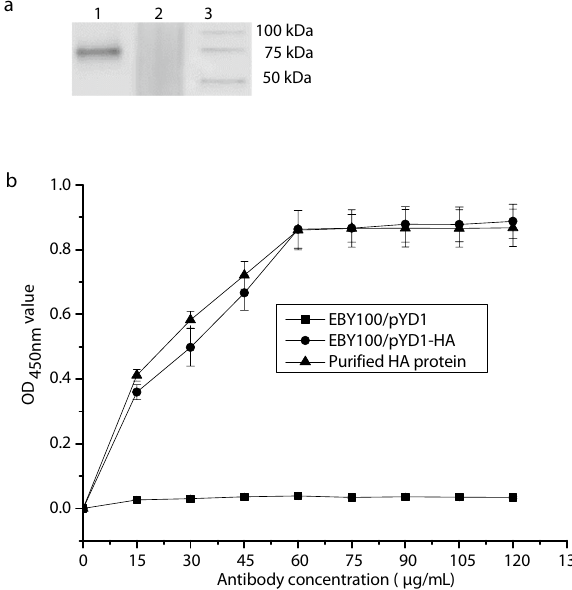
Figure 1. Determinations of expression and quantification of EBY100/pYD1-HA. ( a ) The display of cropped Western blots. Lane 1: EBY100/pYD1-HA; Lane 2: EBY100/pYD1; Lane 3: Western blot marker (Precision Plus Protein™, Bio-Rad). ( b ) Quantification of EBY100/pYD1-HA expressing the HA protein measured by ELISA. The OD 450 nm values were obtained from three independent experiments. The bar indicates the means ± SDs. Full-length Western blots are presented in Supplementary Figure